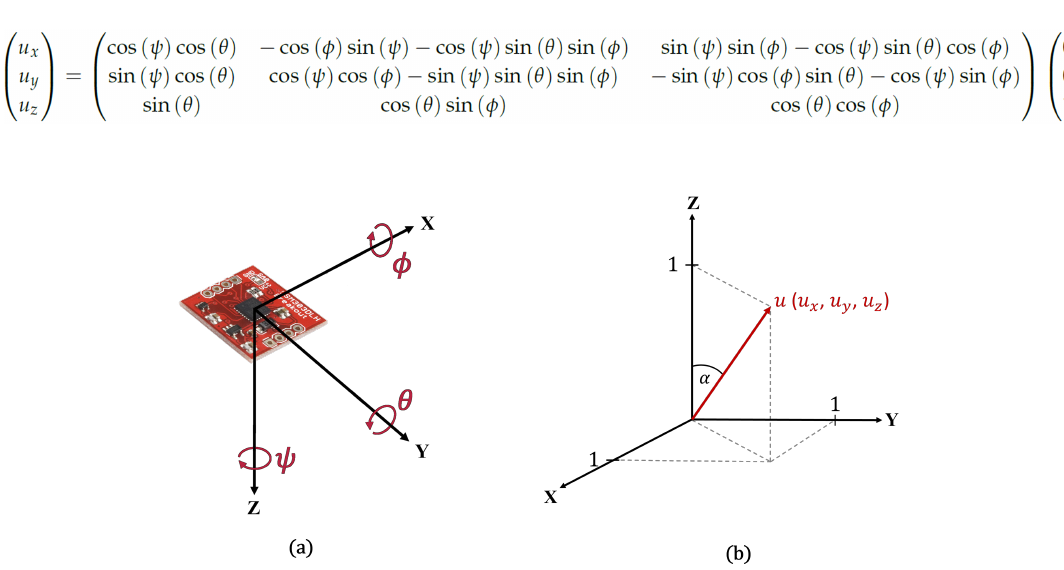
Figure 4. ( a ) The Printed Circuit Board (PCB) axis system in each DOM and yaw ( ψ ), pitch ( θ ), and roll ( φ ). ( b ) The absolute coordinate system for a DU uses a unitary point to locate the relative position of the DOMs of the